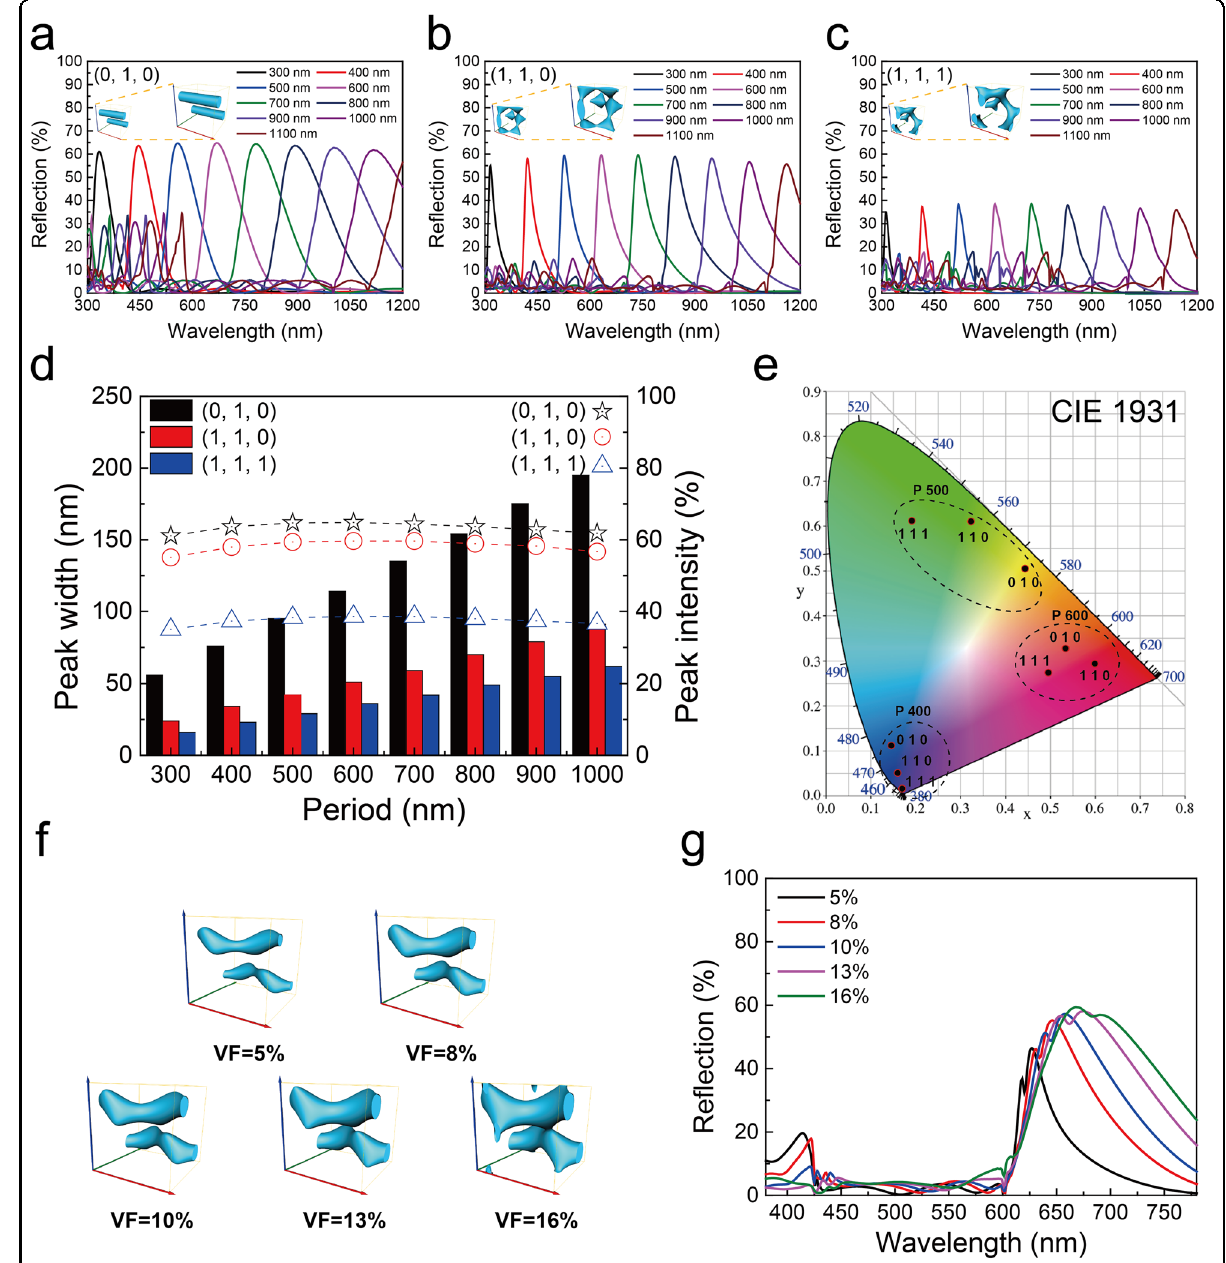
Fig. 4 Optical response under different periods and VFs. a-c Re fl ection spectra at states (0, 1, 0), (1, 1, 0), and (1, 1, 1), respectively. d Peak width and intensity under different periods. e CIE coordinates of the colors from the simulated re fl ectance. “ P ” denotes a period. f Structural model at state (2/3, 1, 1/3) under different VFs (the other states are shown in Supplementary Fig. S8). g Re fl ection spectra corresponding to the structures in ( f